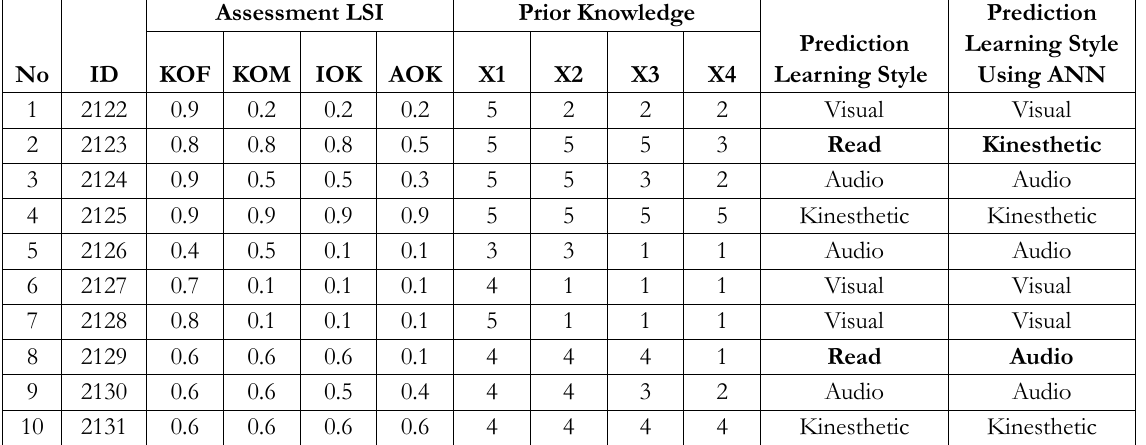
Table 4. Result LSI and Prior Knowledge